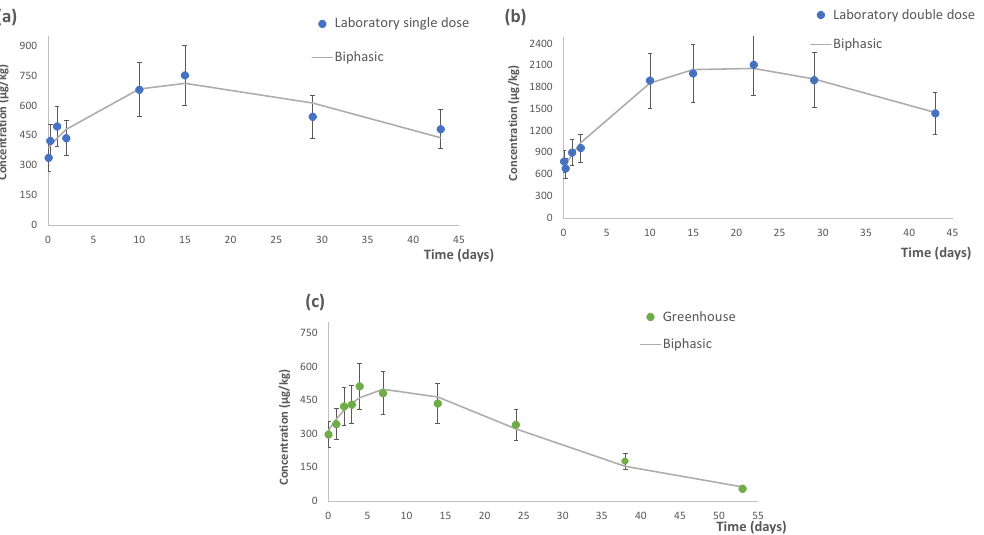
Figure 1. Biphasic kinetic model of flutriafol in laboratory trials at two concentration levels, ( a ) single dose (recommended dose by the manufacturer at 0.09 %) and ( b ) double dose (0.18 %), and ( c ) in greenhouse experiment (0.09 %) ( n = 3).